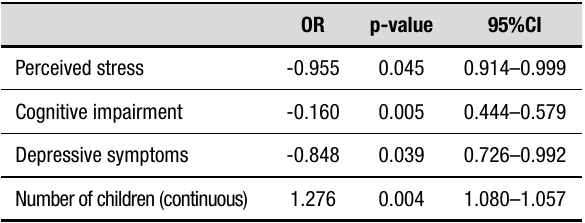
Table 2. Multiple logistic regression investigating the predictors of family dysfunction in older spousal caregivers (n=298), São Carlos, SP, Brazil,